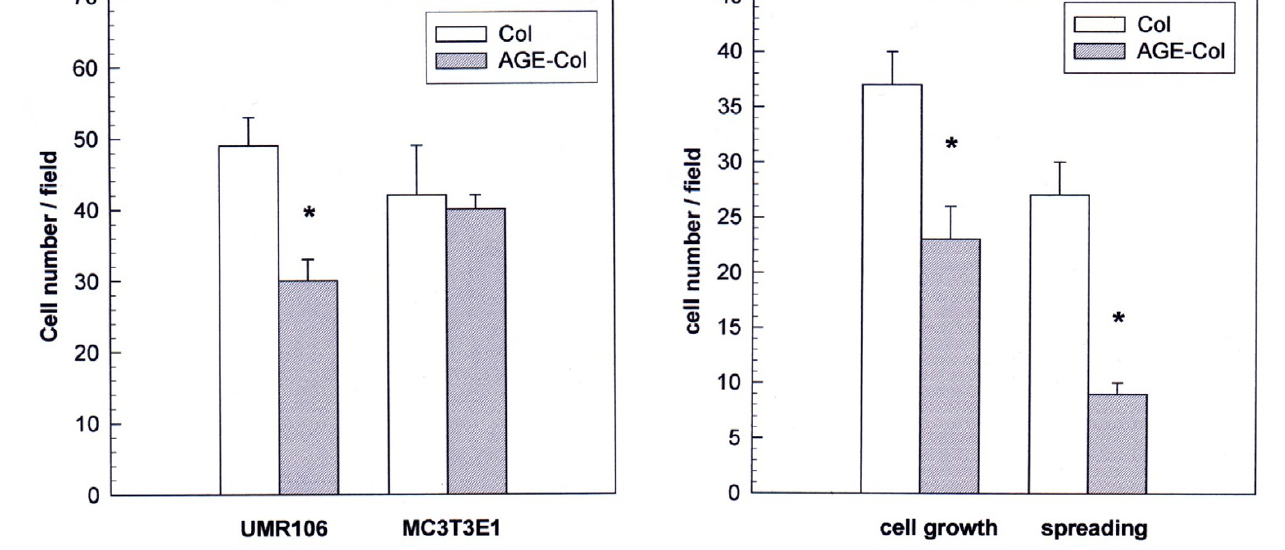
Figure 1 Effect of an AGE-modified type I collagen matrix on cell adhesion. UMR106 and MC3T3E1 osteoblast-like cells were incubated on an unmodified collagen matrix or an AGE-colla- gen matrix for 1 hour at 37 ° C. Cells adhering to the matrices were fixed, stained with Giemsa and counted microscopically at a magnification of 400X. Results are given as the number of cells counted per field, and are expressed as the mean ± SEM. Differences between collagen vs. AGE-collagen are as follows: * p < 0.001